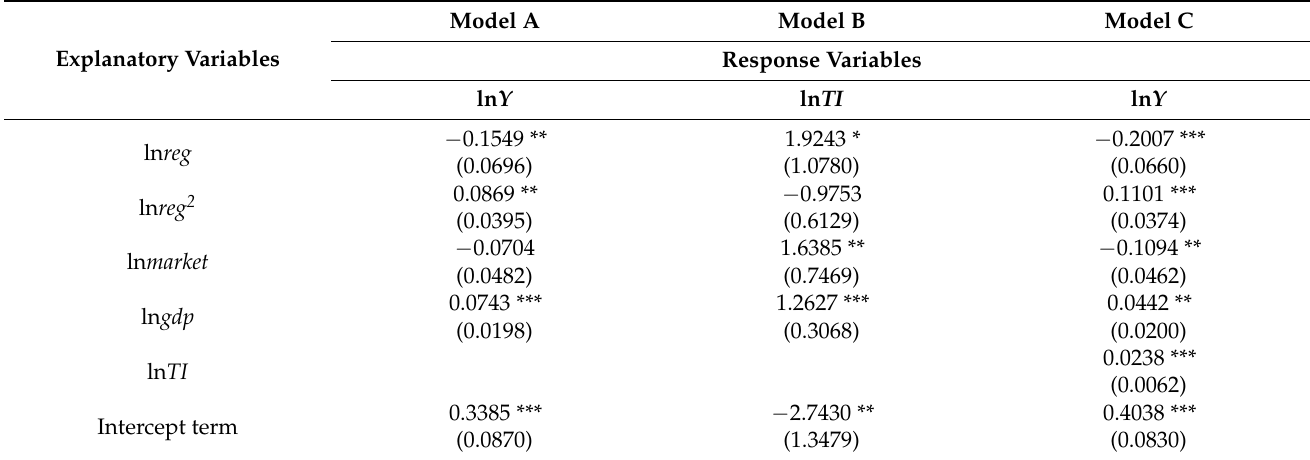
Table 5. Model regression